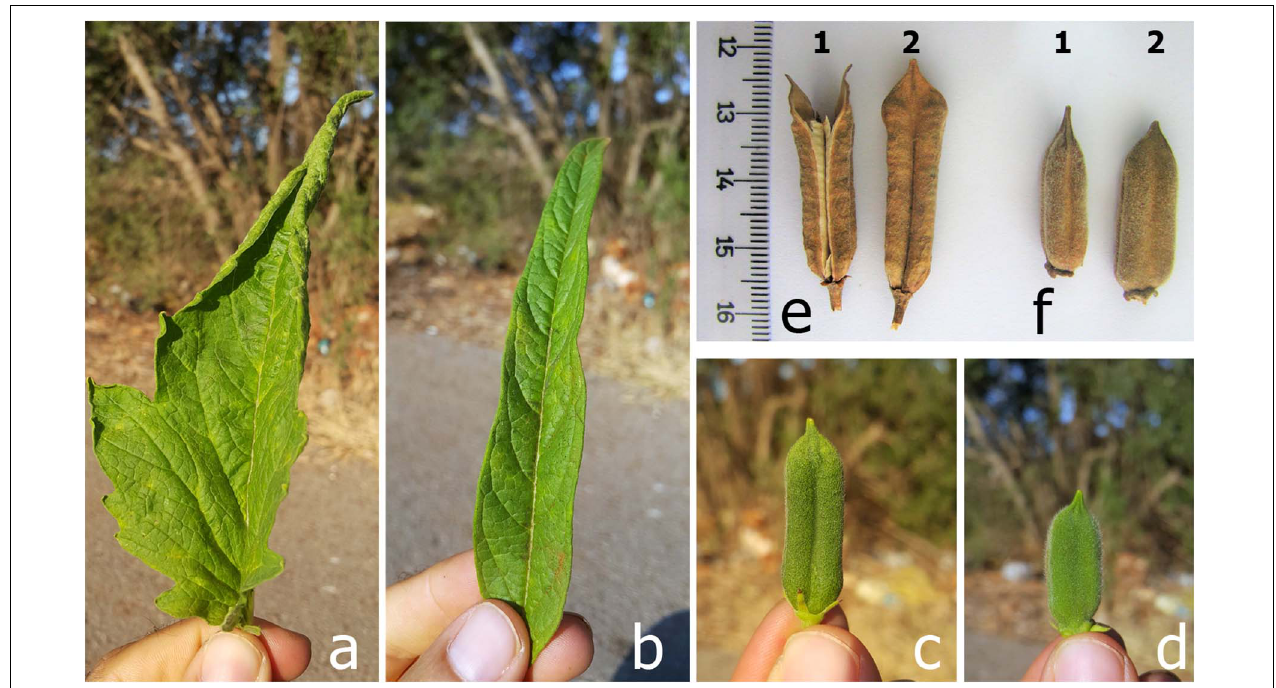
FIGURE 1 | The morphological differences for capsule shattering and non-shattering genotypes. (a,d,f) Leaf, capsule-forming stage, and harvested capsule of the non-shattered capsule phenotype, respectively. (b,c,e) Leaf, capsule-forming stage, and harvested capsule of the capsule shattering phenotype, respectively.